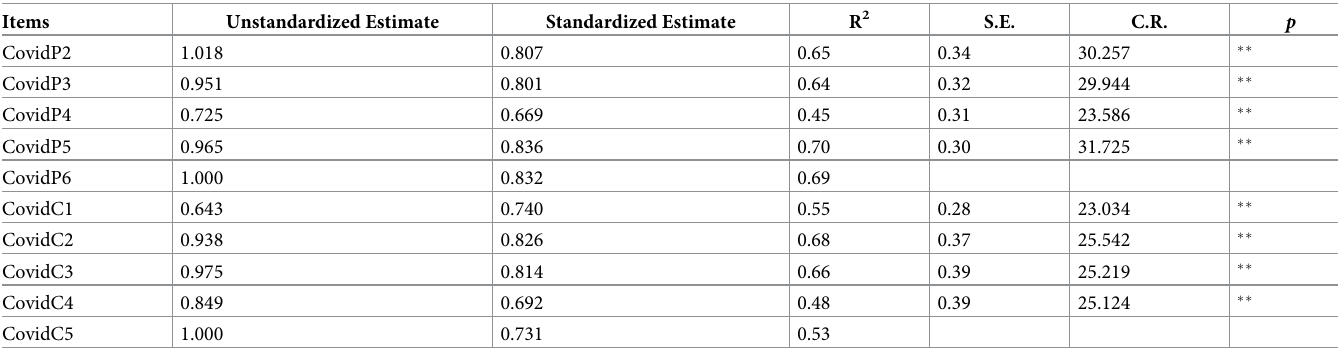
Table 5. Result of CFA CB-SEM. Items Unstandardized